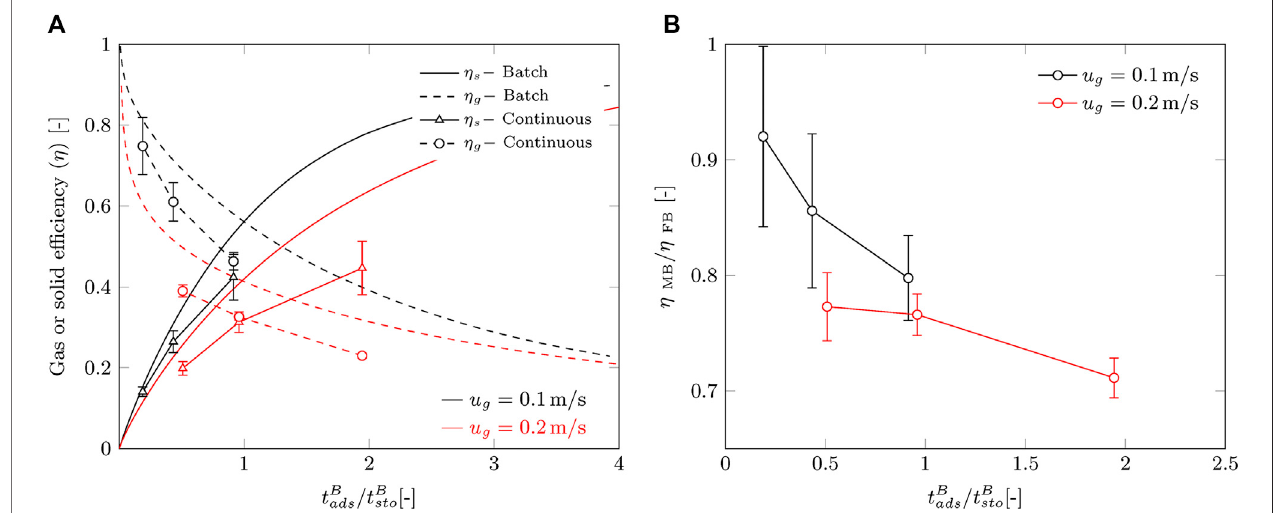
FIGURE8| Comparison ofthecontinuousprocesswiththebatchprocess.Errormarginsrepresent thestandarddeviationbyerrorpropagation. (A) Gasandsolid ef fi ciency according to Eqs (1) – (4) and (B) the ratio of the ef fi ciency between batch and continuous.